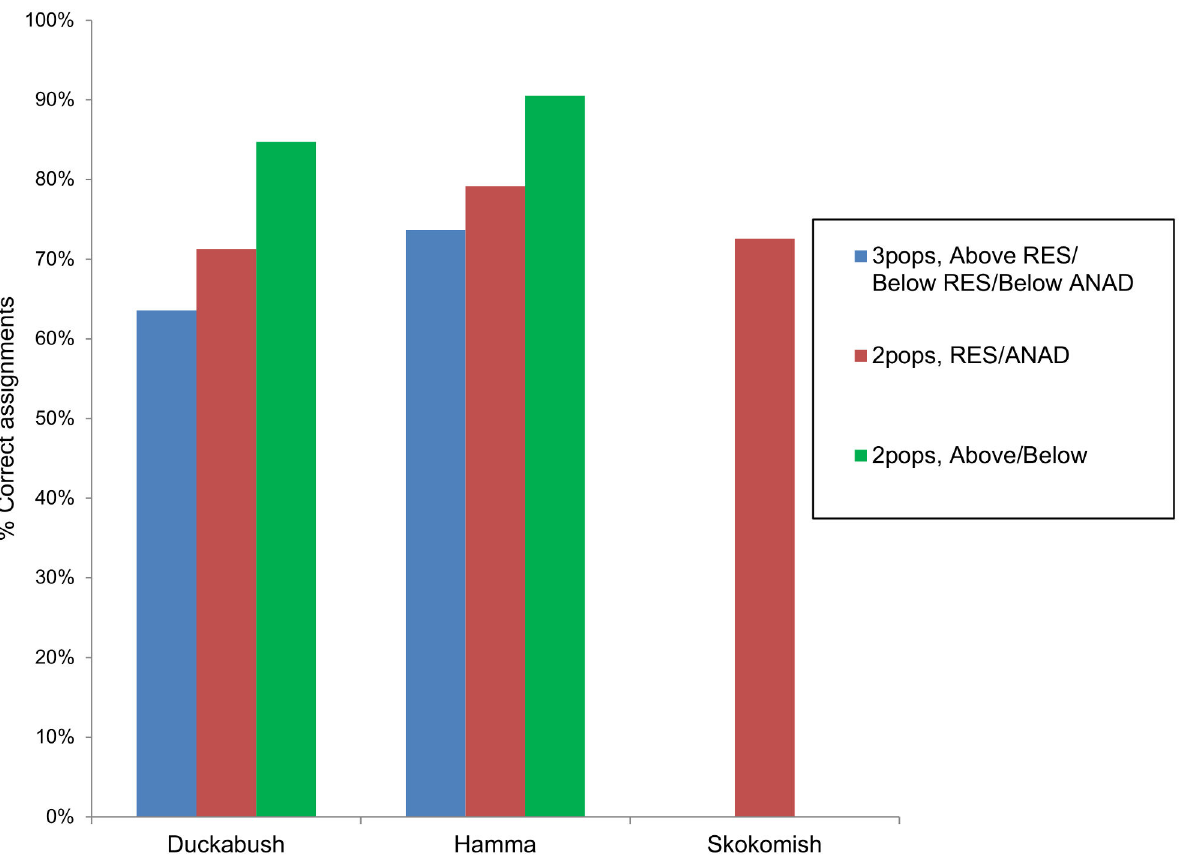
Figure 4. Leave-one-out assignment tests for resident (RES) and anadromous (ANAD) O. mykiss sampled from three rivers. Samples are tested for the percent of correct assignments to population of origin given different population structure configurations depending on sample’s location above or below a barrier to upstream migration, and life history